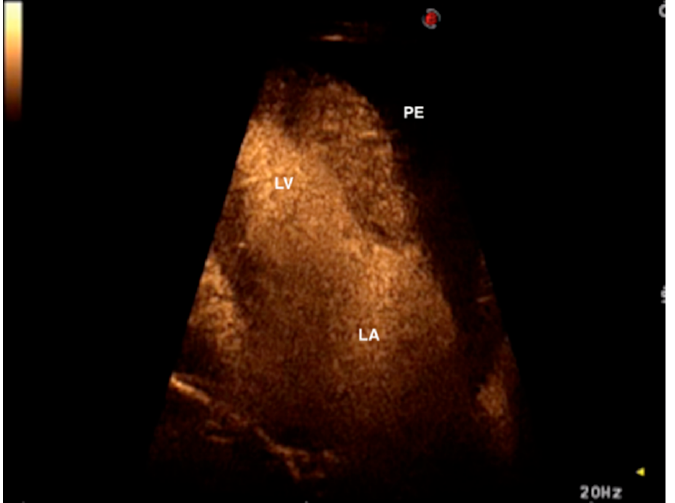
Figure 2. Contrast-enhanced echocardiographic image (left apical 4-chamber view) showing no evidence of microbubbles in the pericardial space after the complete opacification of the cardiac chambers. PE, pericardial effusion; LV, left ventricle; LA, left atrium. Seven days after the discharge, the dog suddenly died, and a complete necroscopy was performed. At the opening of the thoracic cavity, the pericardial sac was thickened and edematous; the pericardial cavity contained only a small amount of serosanguineous fluid; in the left atrial lumen, multiple pedunculated 1–2 cm, red-pink, smooth, soft masses were present, adherent to interatrial septum, atrial, and auricular wall; at the base of some masses a red discoloration was present (Figure 3). In the myocardium, multifocal poorly defined whitish areas were present. Mitral and, to a lesser extent, tricuspidal leaflets were thickened and distorted. All the other examined tissues had no gross lesions, including brain. Histologically the main findings were hepatic diffuse centrolobular hemorrhagic necrosis, multifocal tubular renal necrosis. In the heart, apart from severe myxoid degeneration of atrioventricular valves, multifocal to coalescing severe acute myocardial necrosis with calcifications was present, involving about 30–40% of myocardium, both in the left and right ventricular free wall and interventricular septum; the left atrium contained multifocal mural thrombosis (Figure